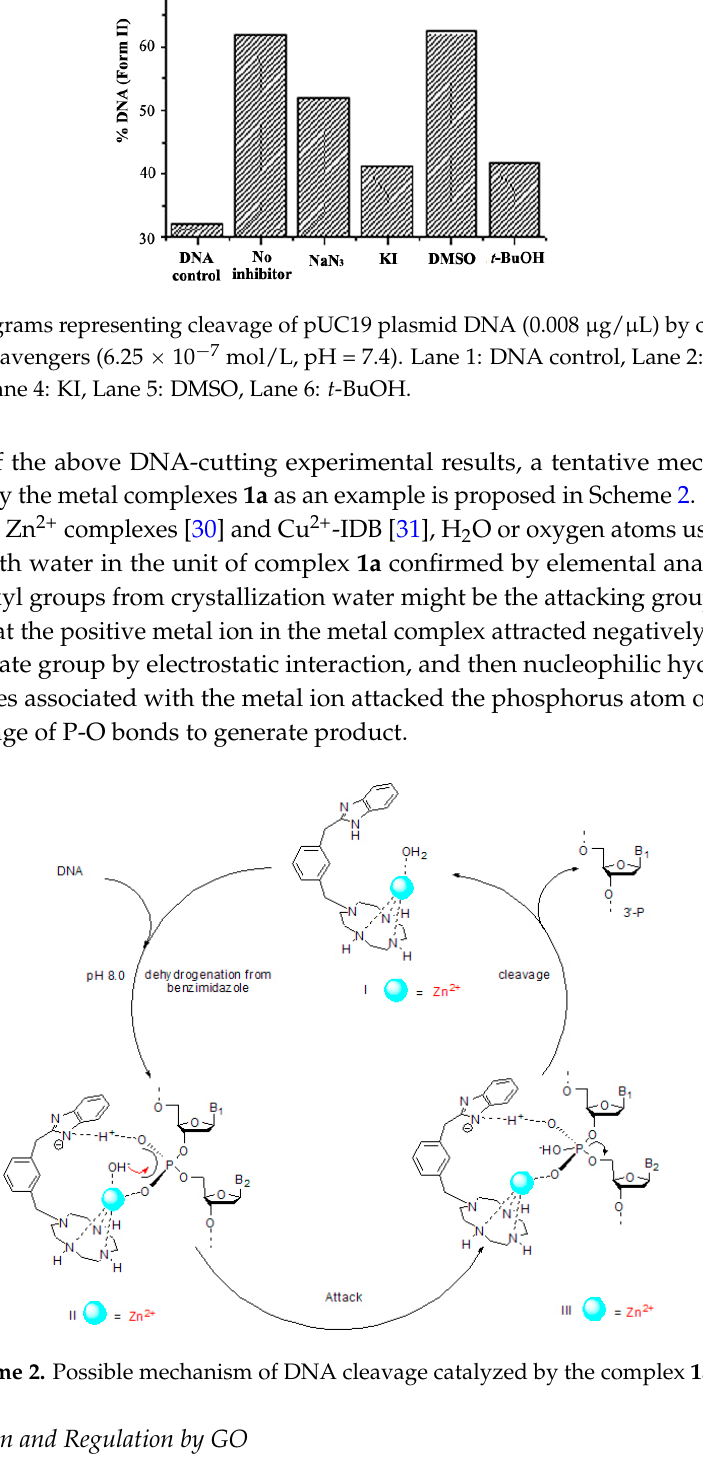
Figure 9. Histograms representing cleavage of pUC19 plasmid DNA (0.008 µg/µL) by compound 1b typical radical scavengers (3.13 × 10 − 4 mol/L, pH = 7.4). Lane 1: DNA control, Lane 2: no inhibitor, Lane 3: NaN 3 , Lane 4: KI, Lane 5: t -BuOH, Lane 6: DMSO.